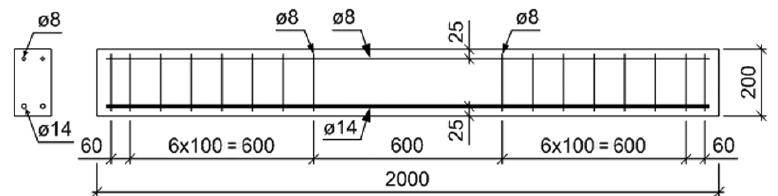
Fig. 3. Reinforcement